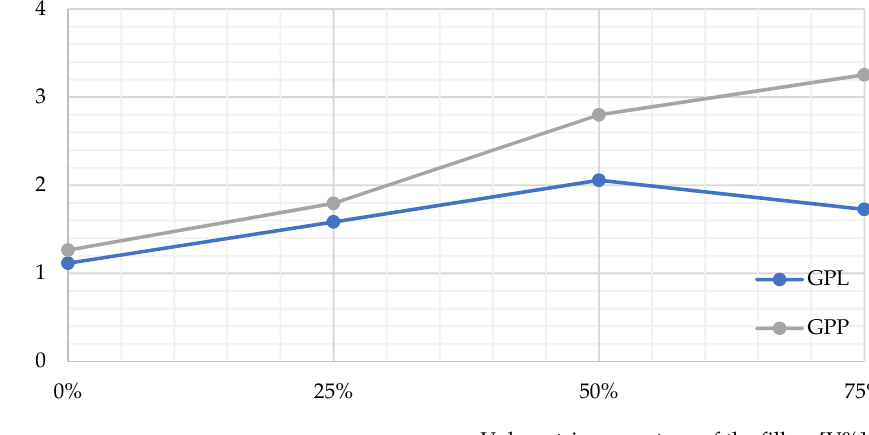
Figure 7. The flexural strengths profiles of GPL and GPP on the relative fillers expressed as a volumetric percentage.